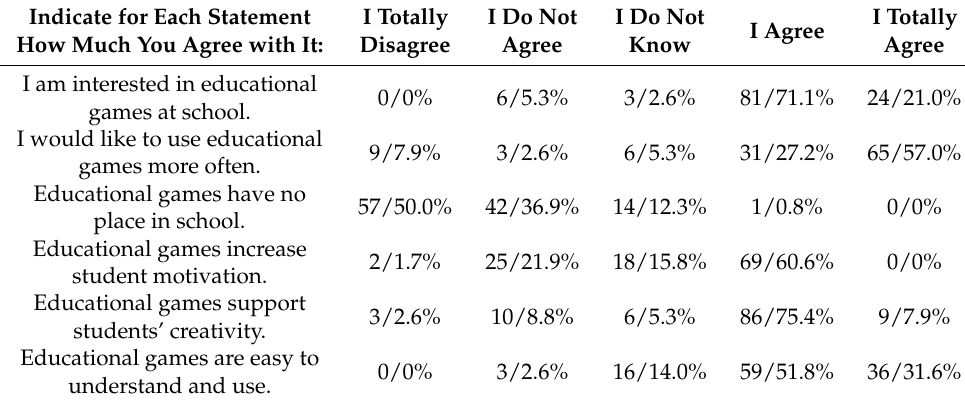
Table 1. Questionnaire—educational games with results.